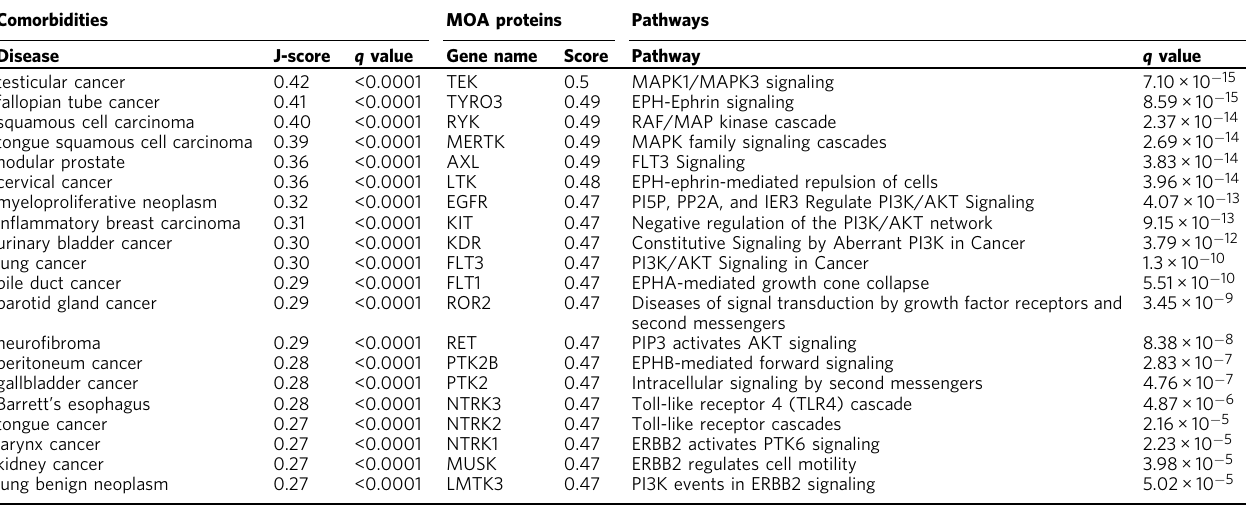
Table 4 Top 20 comorbidities (excluding same disease pair, (i.e., OC-OC)), top 20 comorbidity enriched MOA proteins (with respect to original disease), and top 20 pathways associated with the prediction OC results.